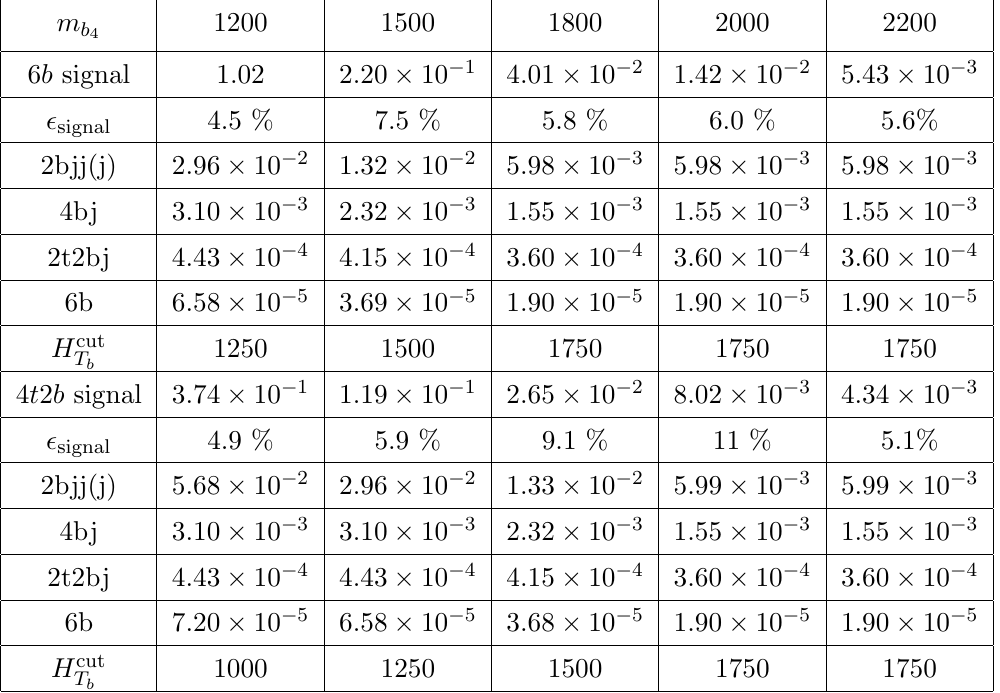
Table 3 . Signals pp